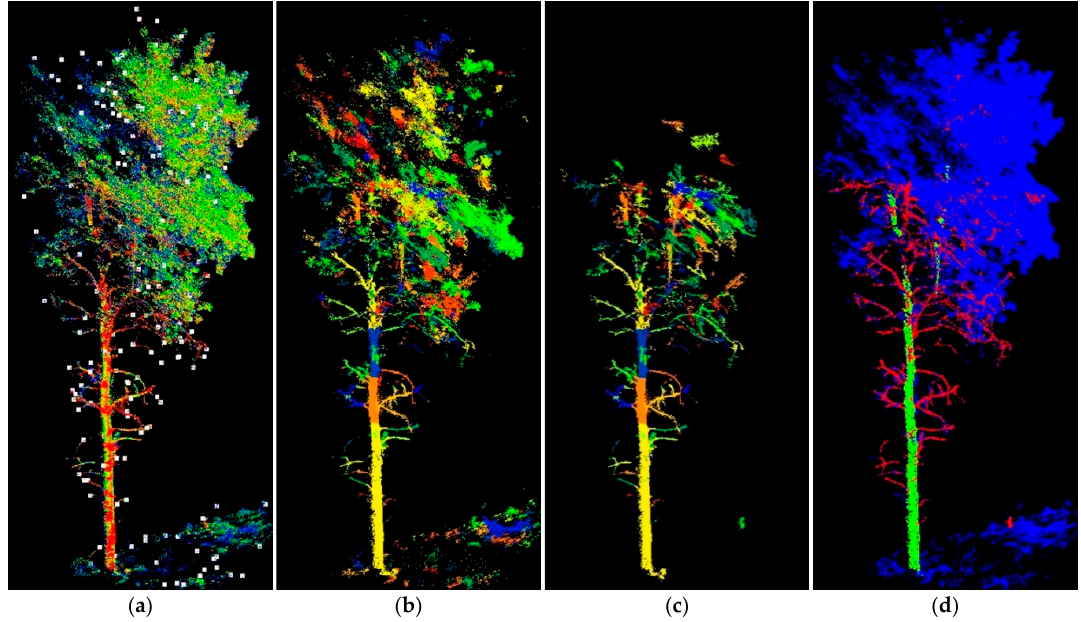
Figure 6. Example of preparing aspen reference sample (‘aspen 3’): ( a ) clipped point clouds colored by laser intensity, overlaid with branch tip extraction in white dots; ( b ) region-growing segments in random colors; ( c ) segments with only stem and branches; and ( d ) reference tree with stem, branch, and other components classified in green, red, and blue colors, respectively. This sample area covers two trees: one exhibiting detailed stem form and the other showing only partial upper stem due to occlusion.